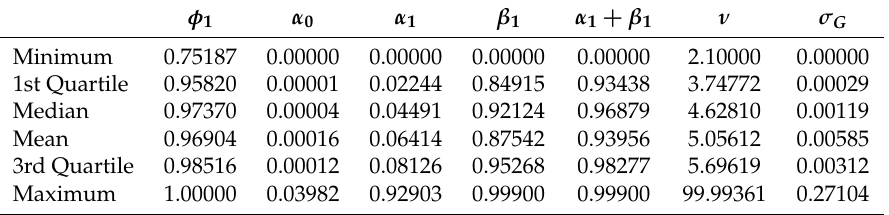
Table 3. Summary statistics of parameter estimates, when fitting AR(1)-GARCH(1,1) models to the 41,069 sets of cointegration residuals between the DAX 30 constituents identified on 249 trading days in 2014.